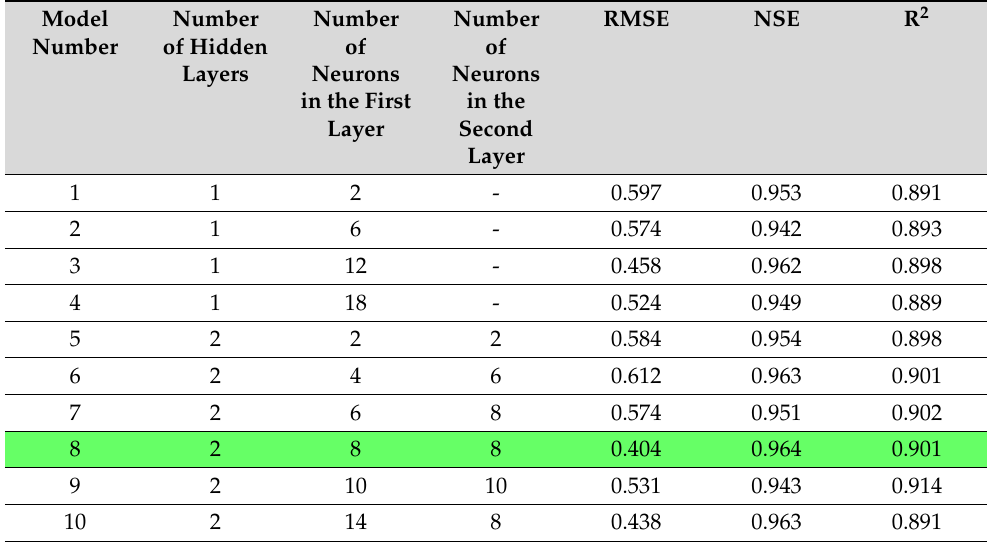
Table 3. Examples of results obtained from the use of a different number of layers and neurons for S1.